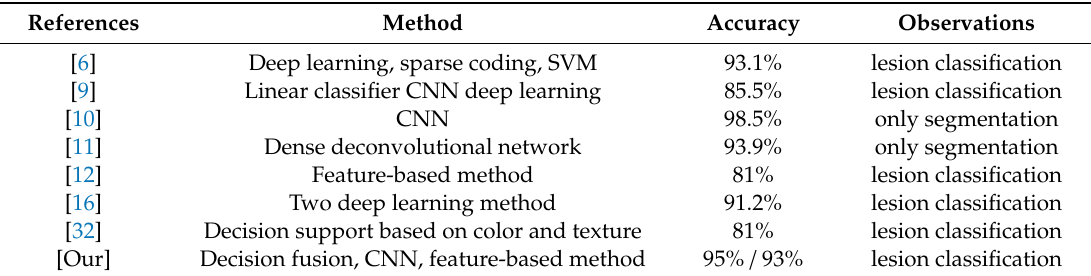
Table 6. Comparison results of